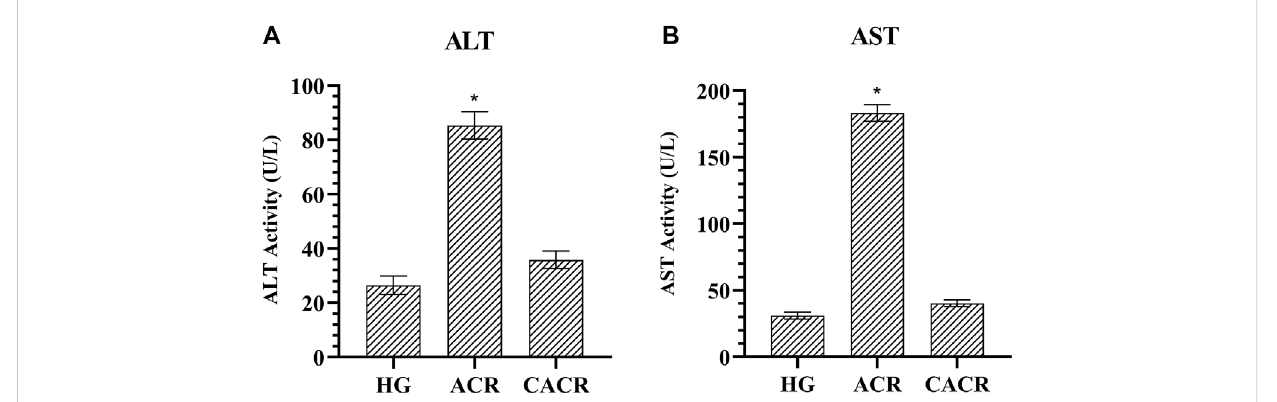
FIGURE 4 (A,B) Analysis of ALT and AST levels in liver tissues of rats in experimental groups. n = 6/each group. The bars show the mean ± standard deviation. * p < 0.001, ACR group is compared with the HG and CACR groups. ** p > 0.05, CACR group is compared with the HG group.